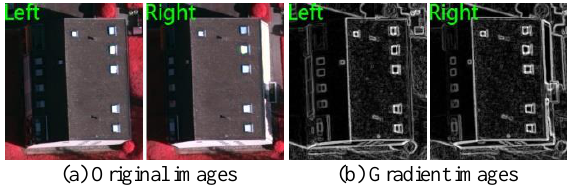
Figure 3. The complementary effect of edge information between the overlapped images